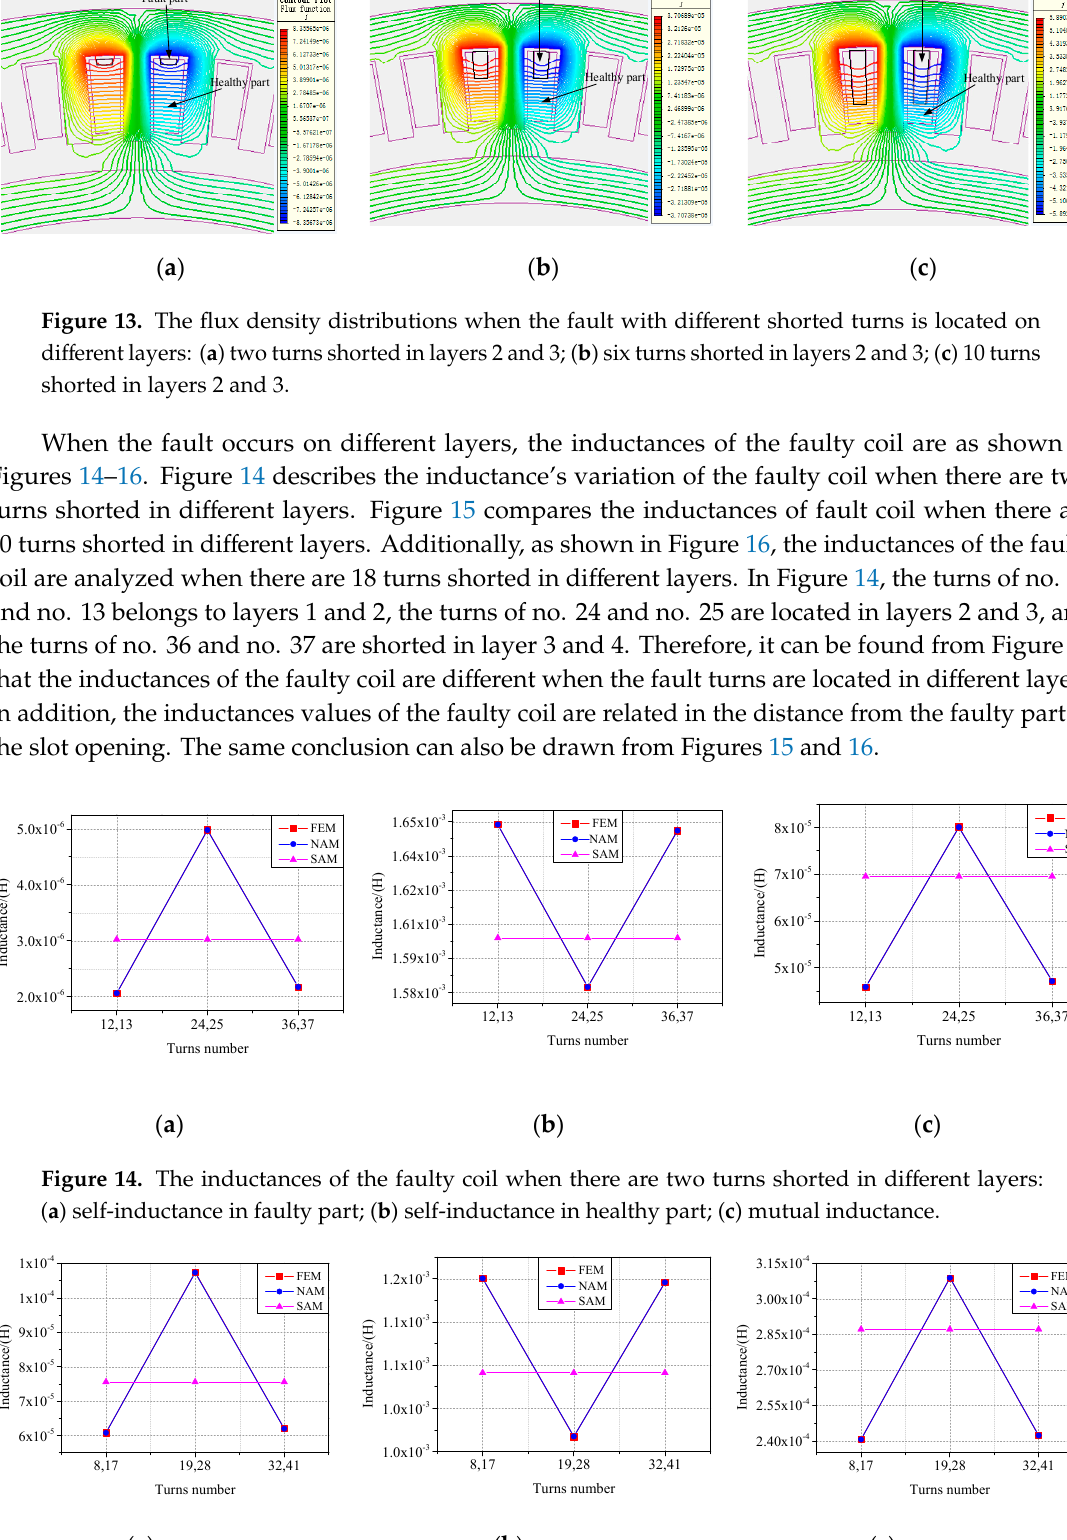
self-inductance in faulty part; ( b ) self-inductance in healthy part; ( c ) mutual inductance.